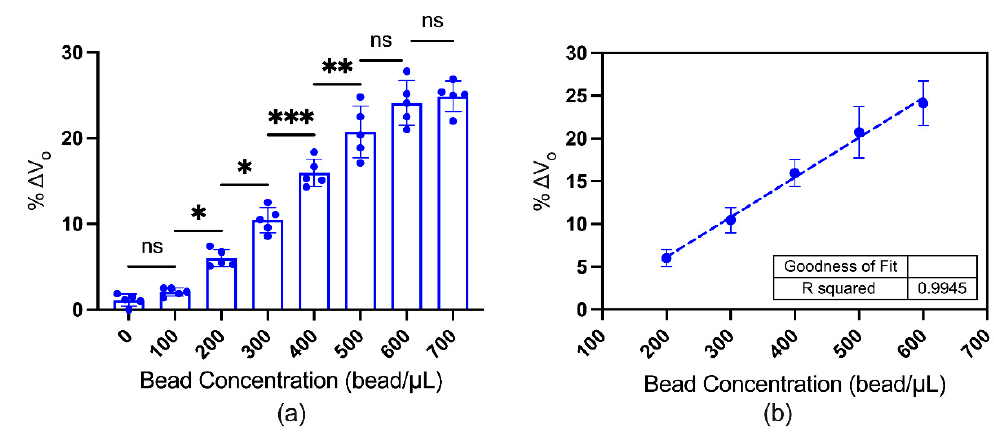
Figure 5. Magnetic beads quantification with the developed EPHE sensor. ( a ) Sensor measurements of the magnetic beads’ droplet with different concentrations. The column indicates the mean, and the error bar indicates the standard deviation, where n = 5 per group. Each dot represents the individual measurement of different sensors. The statistical significance was based on the ordinary one-way ANOVA (multiple comparison), where p = 0.1234 (non-significant, ns), 0.0332 (*), 0.0021 (**), and < 0.0002 (***). ( b ) The linear relationship between sensor output and bead concentration, where the dot with error bar indicates the mean ± SD and the coefficient of determination (R 2 ) is 0.9945.